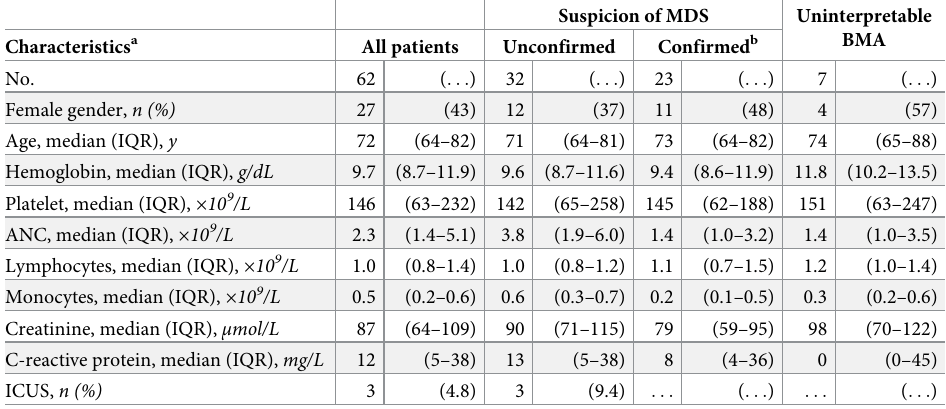
Table 1. Baseline characteristics for consecutive patients with suspicion of myelodysplastic syndromes (n = 62).